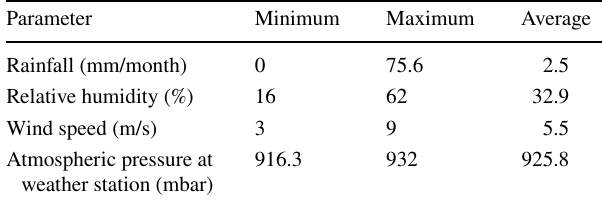
Table 1 Monthly average climatic data for 30 years